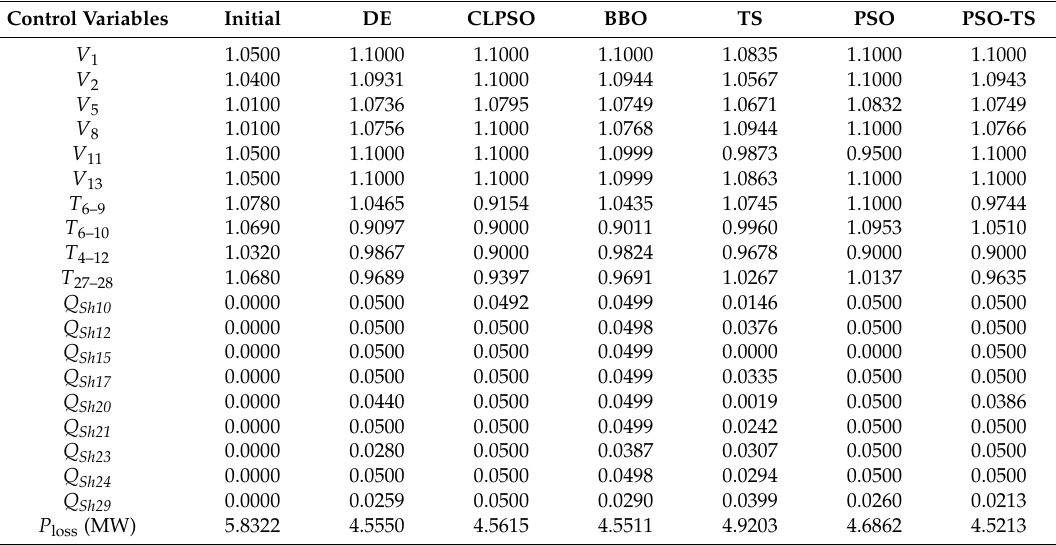
Table 4. Experimental results of TS, PSO and PSO-TS algorithms (Case 2).